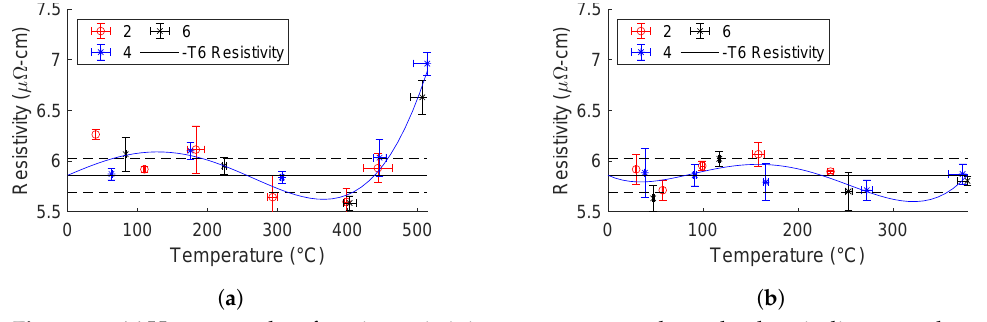
Figure 16. 16 Hz test results of ex situ resistivity measurements, legend values indicate number of pulses applied; Dashed black lines represent a single standard deviation of the -T6 baseline resistivity; ( a ) Air-cooled, air-quenched, ( b ) air-cooled, water-quenched.